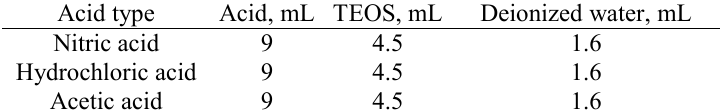
Table 2. Using of Various Acids in sol-gel reaction.